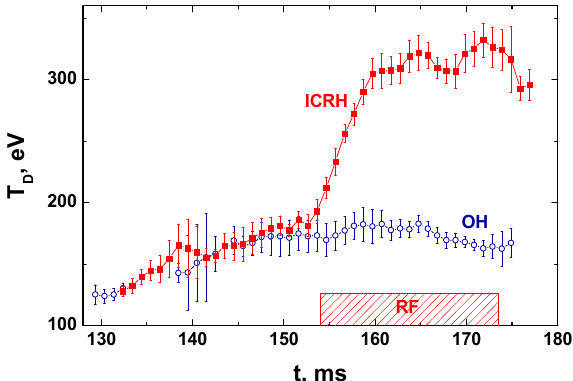
Figure 3. Time evolution of the effective ion temperature measured with NPA in the ICRH experiment and during Ohmic discharges (discharges ##11360–11363). ICRH pulse time is shown by the shaded area. The figure is taken from [41] and reproduced with permission from Springer Nature.